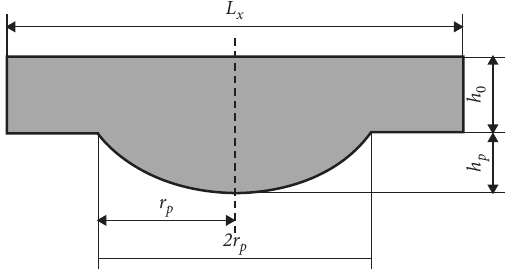
Figure 1: Relationship between oil film thickness and texture depth.